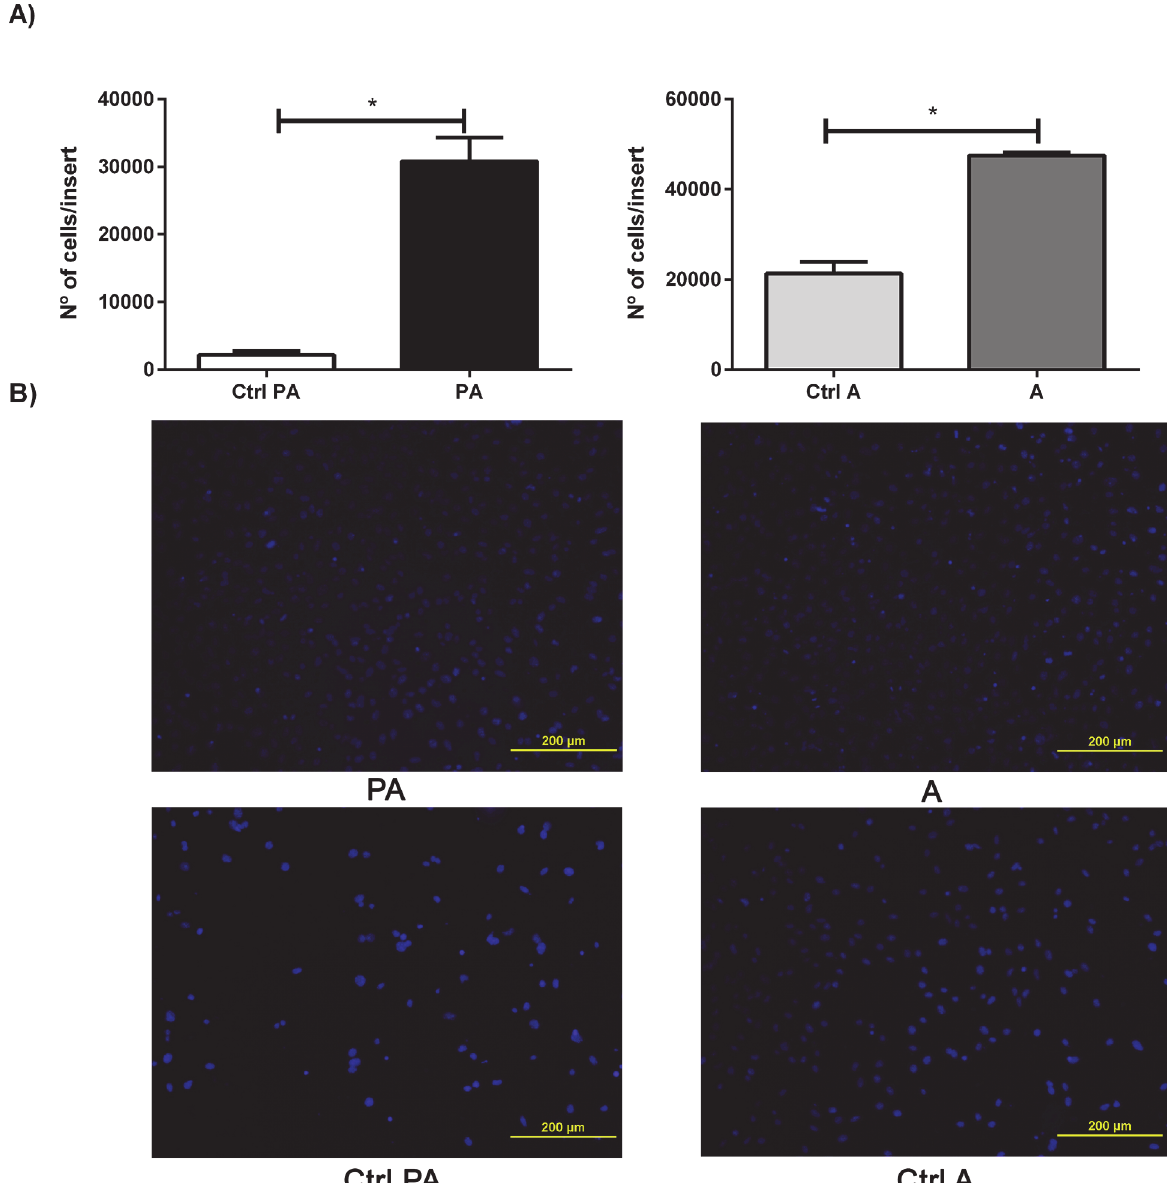
Fig 6. Invasion assay. Number of RM1 cells that invaded the matrigel membrane of the transwell system after 24 h in co-culture with preadipocytes, adipocytes and control media, used to evaluate invasion capacity, which was significantly higher in both co-cultures compared with control media alone ( * p < 0.05 Unpaired T test) (A). Representative images of the cells invading the matrigel membrane for each tested condition